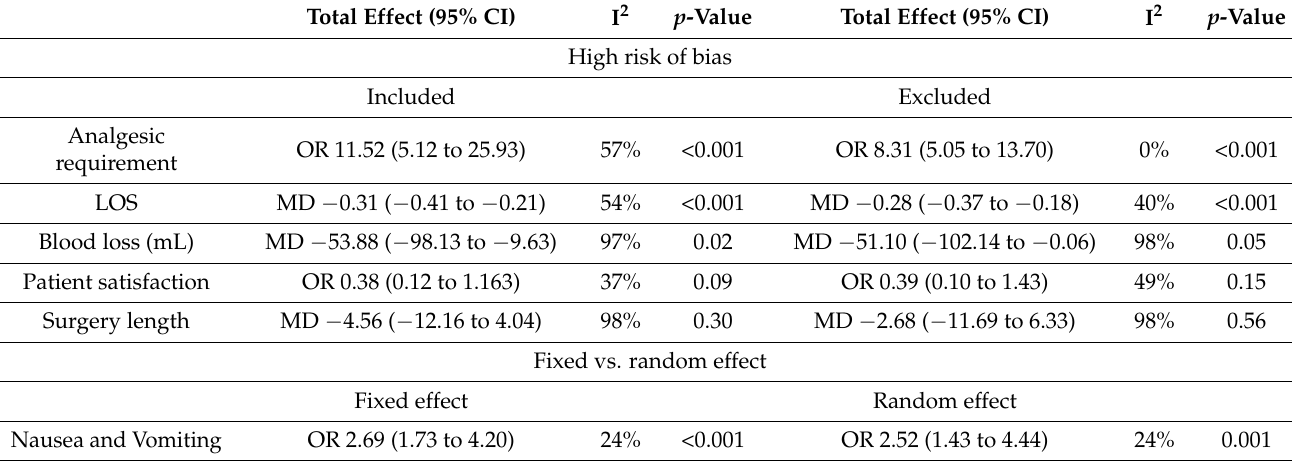
Table 2. Sensitivity